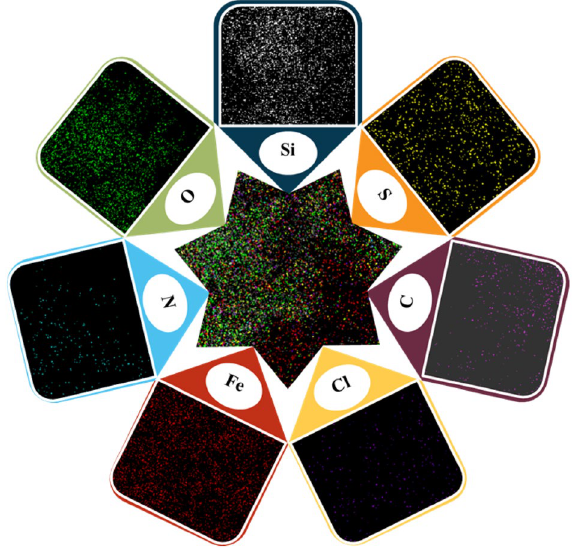
Figure 6. Elemental mapping analysis of the FSiPSS nano-catalyst.